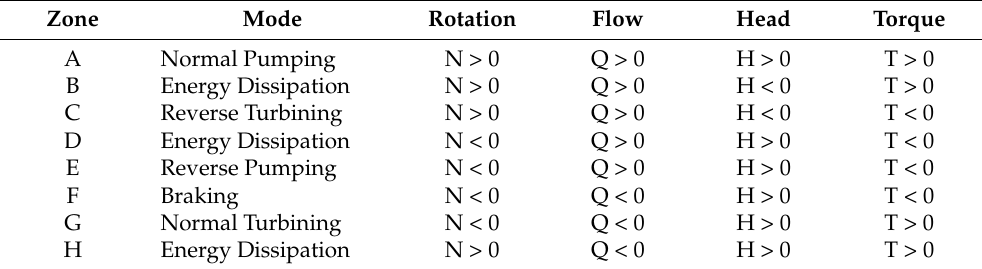
Table 1. Summary of Definitions of Pump Operation Zones [10].